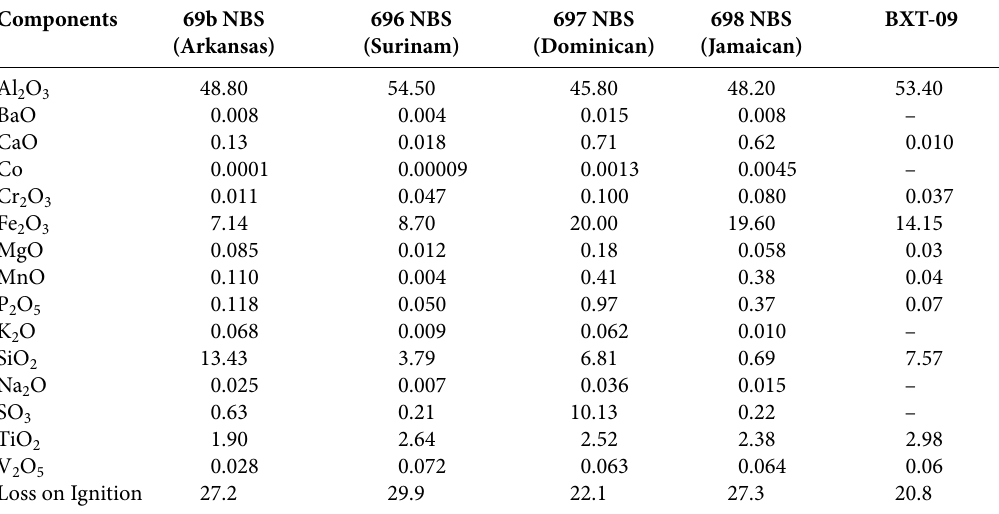
Table 1. Analysis of standard reference bauxite samples according to the certificate (mass %)